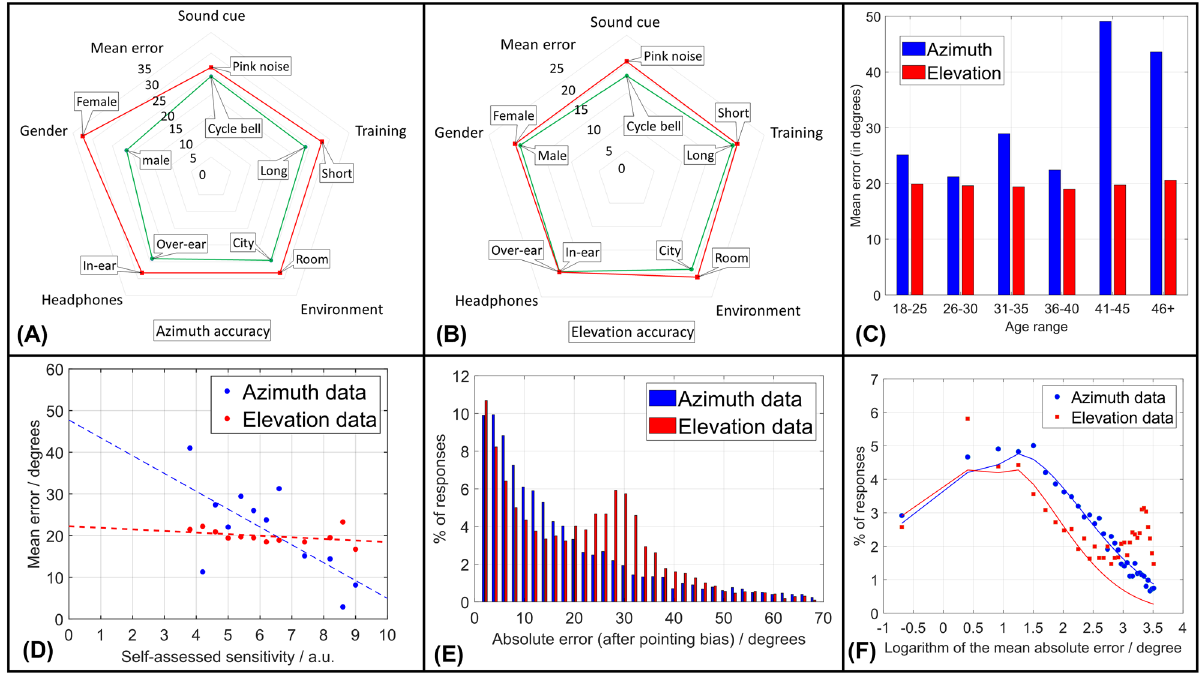
Figure 4. A graphical summary of the discussion. The radar plots ( A , B ) represent the mean absolute error obtained by varying only one of the binary parameters for azimuth ( A ) and elevation ( B ). For instance, by varying the training, the mean absolute error in azimuth changes from 30 different genders, the mean absolute error changes from 33 are represented in ( C ) for age and in ( D ) for sensitivity. The overall distribution of the answers (for azimuth and elevation) is represented in ( E ) using a linear scale, to highlight the second peak in the answers for elevation. The same distributions of the answers are reported in ( F ) with the corresponding Log-Normal fits, for both azimuth and